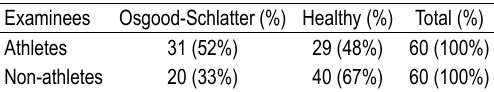
Table 2. osgood-Schlatter disease cumulative incidence of all examinees